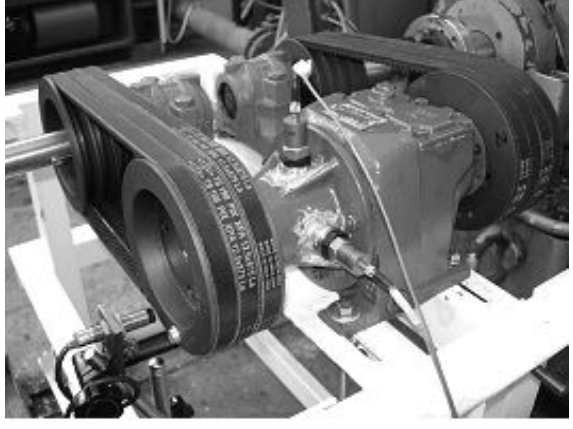
Fig. 3. Gearbox and accelerometers used.